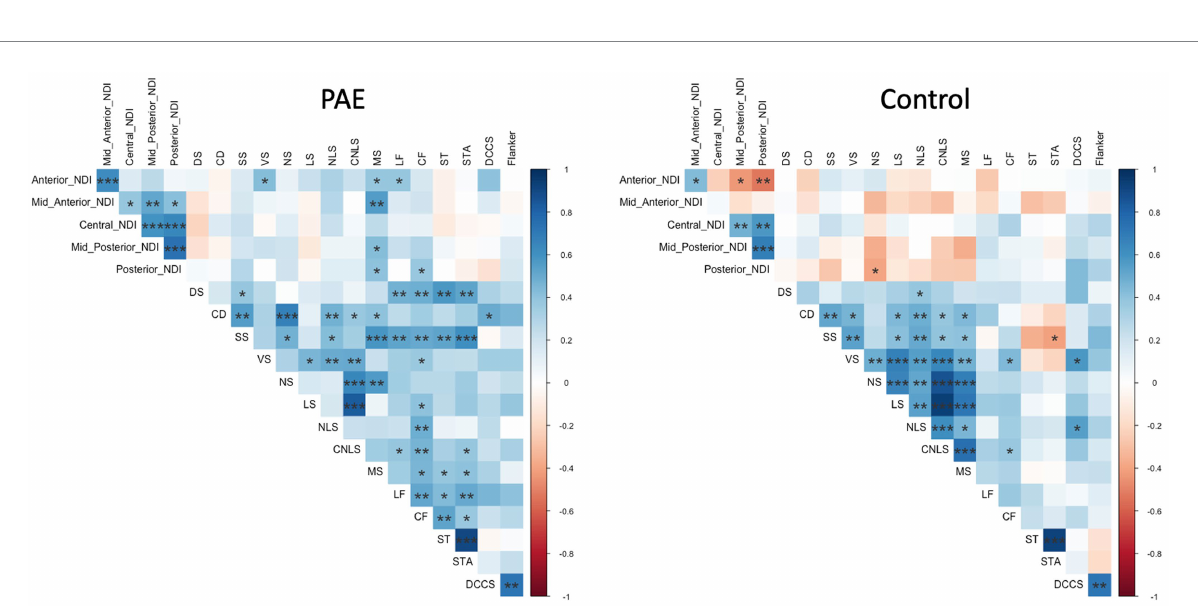
FIGURE 4 Correlation between SPC in corpus callosum NDI and executive function performance. DS, Digit Span; CD, Coding; SS, Symbol Search; VS , Visual Scanning; NS, Number Sequencing; LS, Letter Sequencing; NLS, Number-Letter Sequencing; CNLS, Combined Number-Letter Sequencing; MS, Motor Speed; LF, Letter Fluency; CF, Category Fluency; ST, Switching Total; STA, Switching Total Accuracy; DCCS, Dimensional Change Card Sort; blue shaded cells indicate positive correlations; red shaded cells indicate negative correlations. * p < 0.05, ** p < 0.01, *** p <